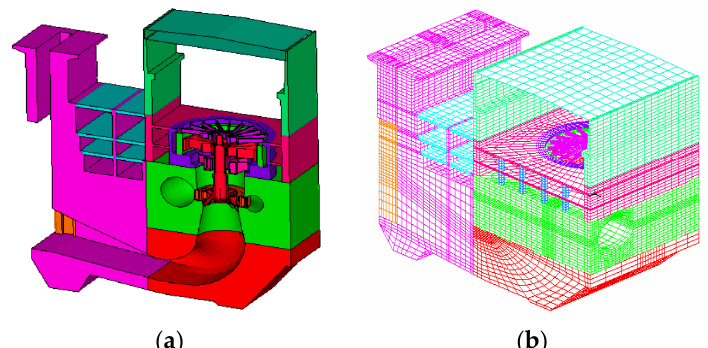
Figure 3. Cross-section diagram and 3D structured grids for the solid domain. ( a ) River-along section diagram, ( b ) 3D structured grids.